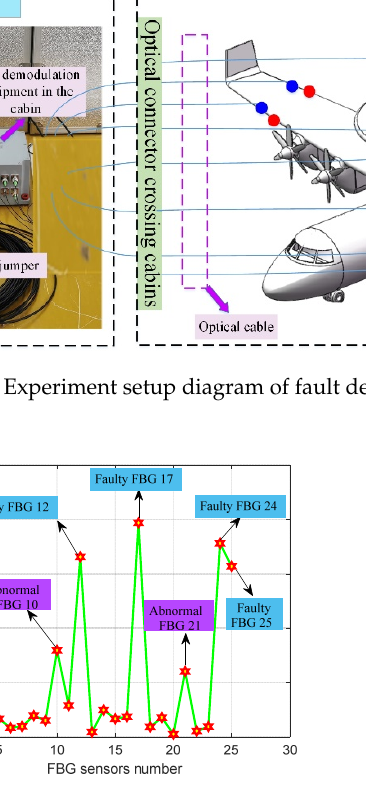
Figure 11. Fault detection results of 25 FBG sensors on airplane. Table 4. Features values and synthetical abnormal index of faulty and abnormal FBG sensors.